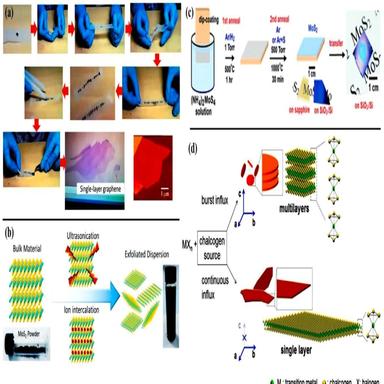
(a) Mechanical exfoliation (i.e., Scotch tape) of a few layers of graphene from bulk graphite. (b) Schematic illustration of sonication-assisted and ion intercalation-assisted exfoliation of MoS2 sheets from their bulk counterparts (Solís-Fern´. (c) Two step decomposition process for the preparation of thin layers of MoS2 over a Si/SiO2 substrate. (d) Schematic representation of the synthetic strategies for the exfoliation of multilayer and monolayer 2D TMD nanoshe